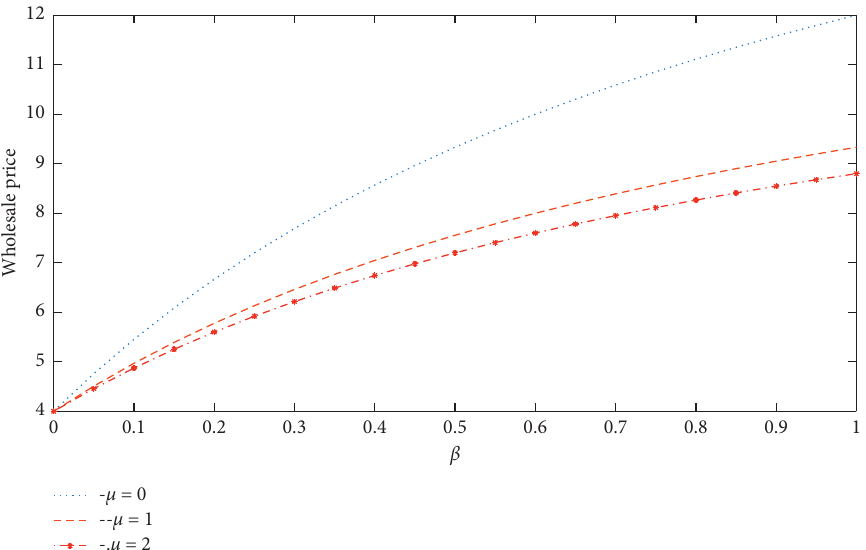
Figure 6: The effect of the cognitive biases on wholesale price w sr ∗ .